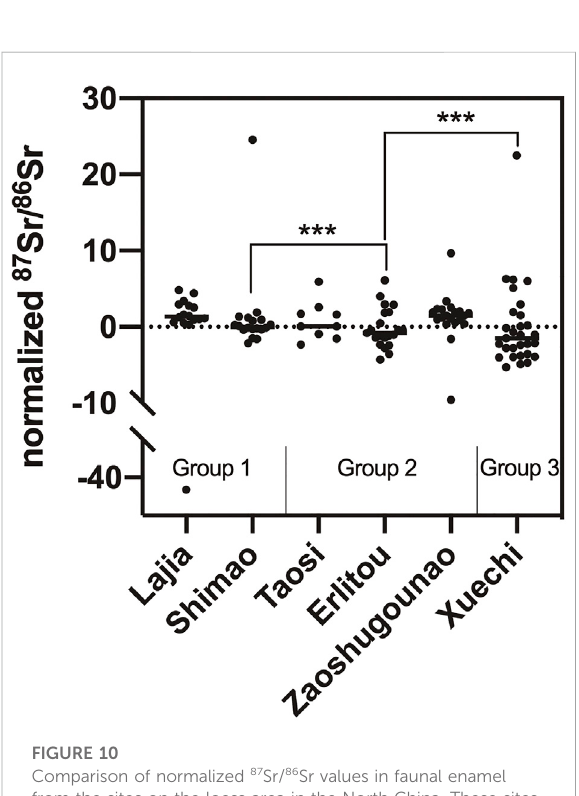
Comparison of normalized 87 Sr/ 86 Sr values in faunal enamel from the sites on the loess area in the North China. These sites were grouped based on their similarity of faunal 87 Sr/ 86 Sr distribution, and the asterisks between groups show the signi fi cant differences at the level of